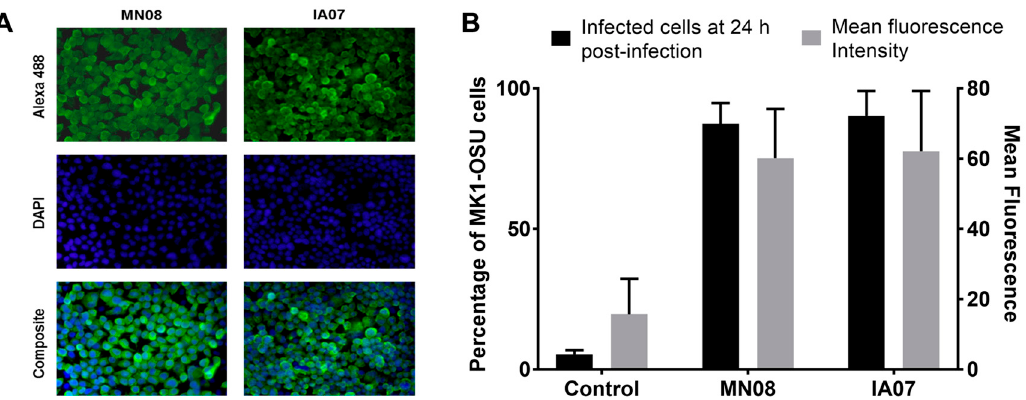
Figure 3. MK1-OSU cells infected with influenza A (MN08 and IA07) virus. ( A ) Cells were infected with MN08 or IA07 viruses at MOI of 0.01 and incubated for 24 h at 37 ◦ C and were fixed with 2% paraformaldehyde in PBS. The fixed cells were incubated with mouse anti-influenza A nucleoprotein and were stained with goat anti-mouse IgG-Alexa 488 (green color) for 1 h. Nuclei were stained using DAPI (blue color) and cells were washed with PBS and examined under an inverted Olympus AX70 fluorescent microscope at 20 × magnification. ( B ) Percentage of MK1-OSU cells infected with influenza A (MN08 and IA07) virus. MK1-OSU were infected at MOI of 0.01 and incubated for 24 h at 37 °C. Following incubation, cells were fixed and permeabilized using BD Cytofix/Cytoperm™. After blocking with 1% goat serum, cells were incubated with primary antibodies against the nucleoprotein of influenza A virus and were stained using goat anti-mouse IgG-Alexa 488. Percentage of cells and mean fluorescence intensity were measured using a FACSCalibur cytometer. Values represent the average for three experiments ± SE.